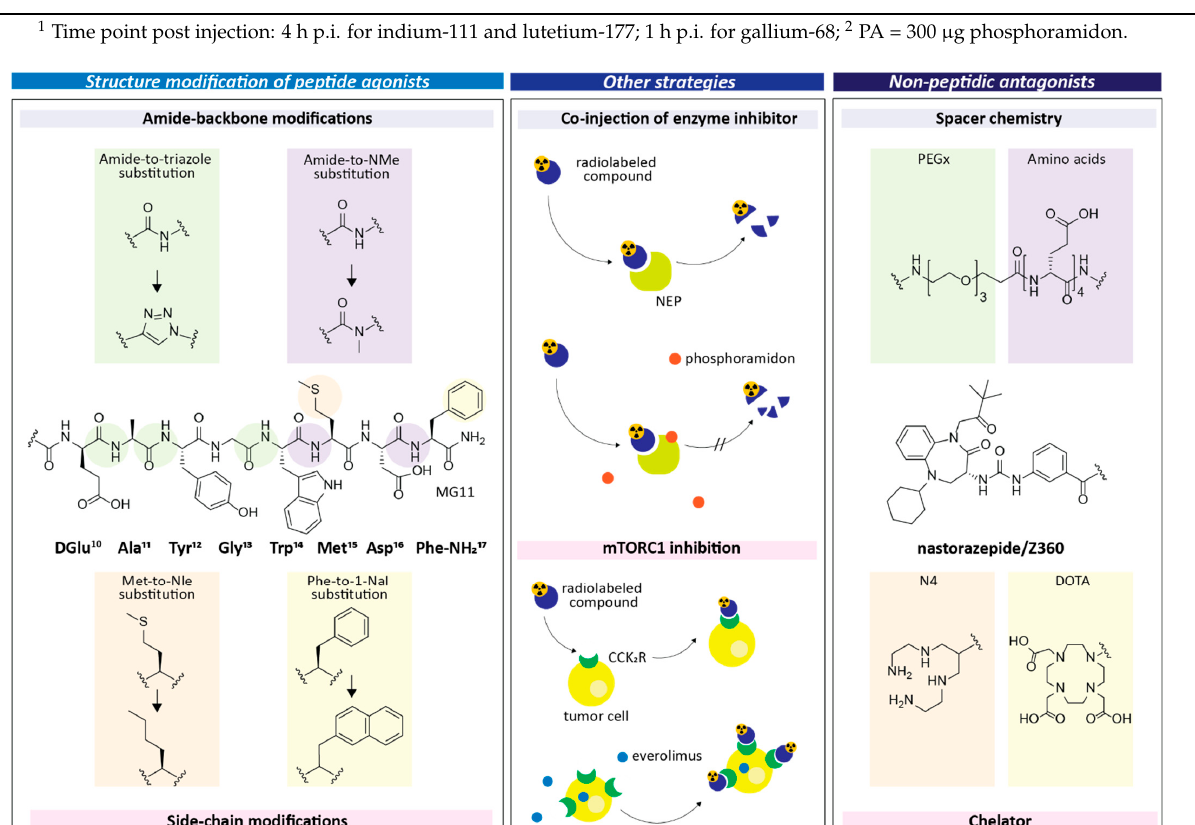
Table 1. Tumor targeting properties of selected radiolabeled CCK2R targeting peptide analogs . CCK2R Targeting Peptide